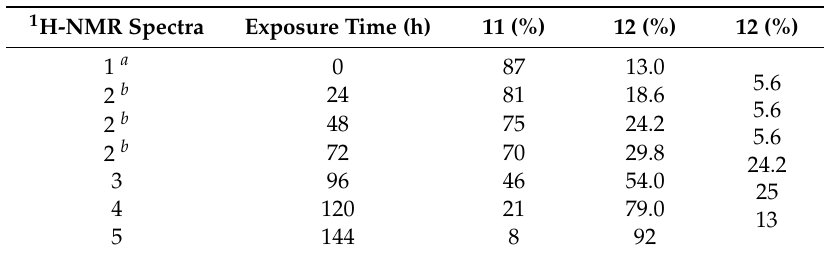
Table 1 . Proportions of compounds 11 and 12 by 1 H-NMR. Table 1. Proportions of compounds 11 and 12 by 1 H-NMR.